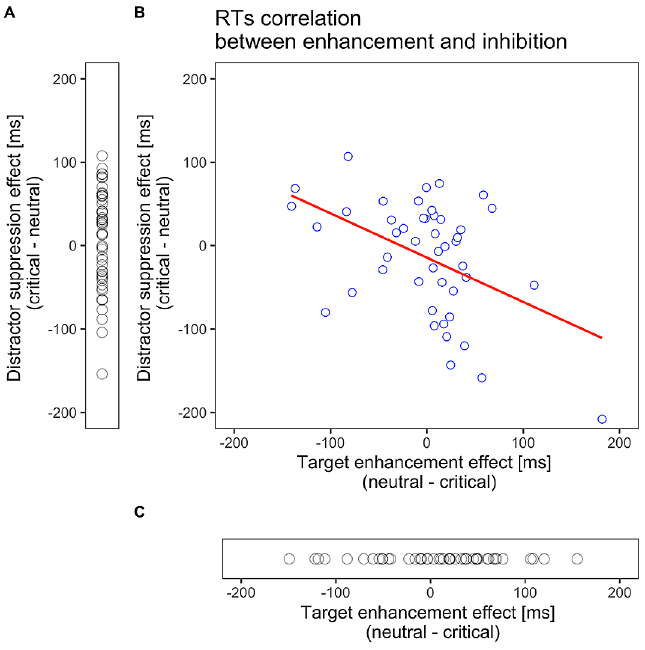
Figure 5. Scatter plots for target enhancement or distractor suppression. (A). Probe effect of all subjects in Experiment 2. Distractor suppression effect varied across subjects, and no group-level effect was observed. (B). Correlations between target enhancement and distractor suppression effects in Experiment 1 for reaction times (RTs). Target enhancement (distractor suppression) indicates a faster RT for the target-colored probe than the neutral probe, while distractor suppression indicates a faster RT for the distractor-colored probe than the neutral probe. The red line indicates the best fit line to the data. The target enhancement and distractor suppression were negatively correlated (Pearson ’ s r = (cid:3) .46, p = .001), suggesting that they are not mutually independent. (C) Probe effect of all subjects in Experiment 3. Target enhancement effect varied across subjects, and no group-level effect was